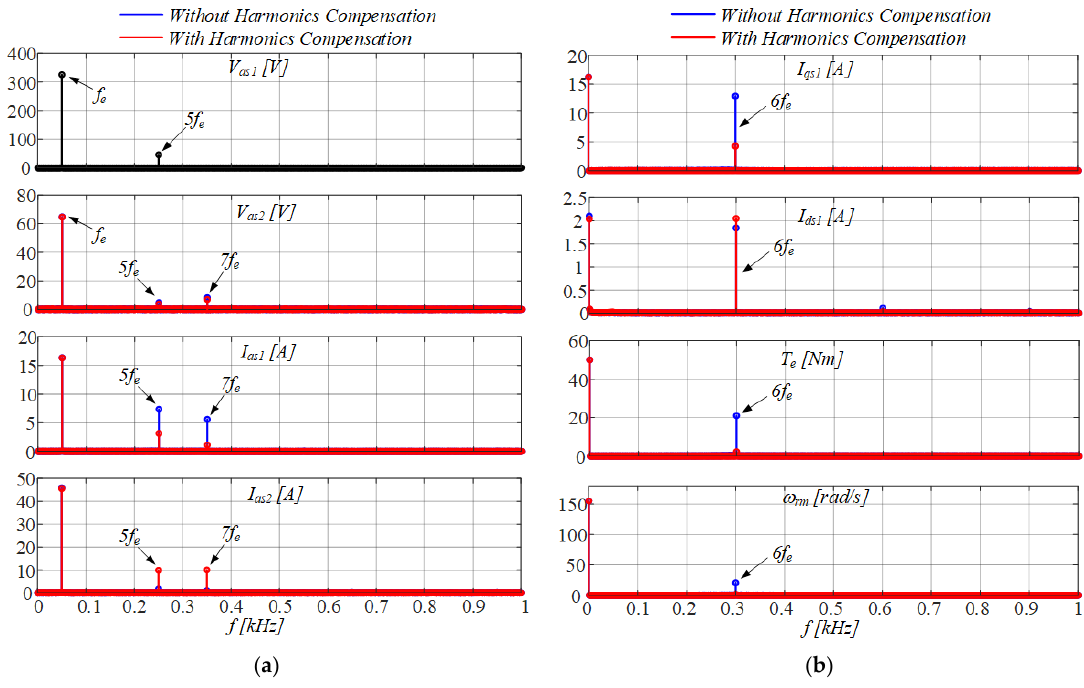
Figure 15. Harmonic content of motor quantities with and without harmonic compensation when a 5th harmonic component is superimposed on the AC grid voltage: ( a ) main winding phase stator amplitude voltage Vas1 , auxiliary winding phase stator voltage amplitude Vas2 , main winding phase stator amplitude current Ias1 , auxiliary winding phase stator amplitude current Ias2 ; ( b ) qd-axes main winding stator current Iqs1 and Ids1 , electromagnetic torque Te , mechanical speed ω rm .